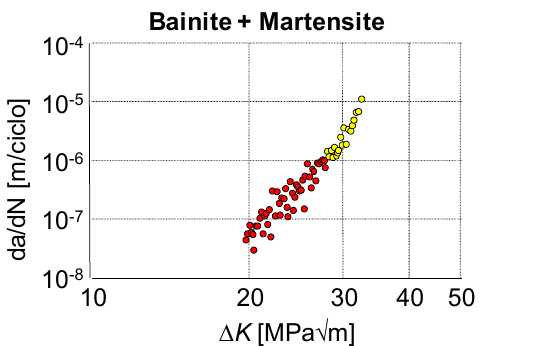
Figura 6: Determinazione sperimentale di curve di Paris per una struttura mista bainitico-martensitica (R= 0,1) . Figure 6: Fatigue crack propagation rate in a mixed bainite-martensite microstructure (R= 0,1).